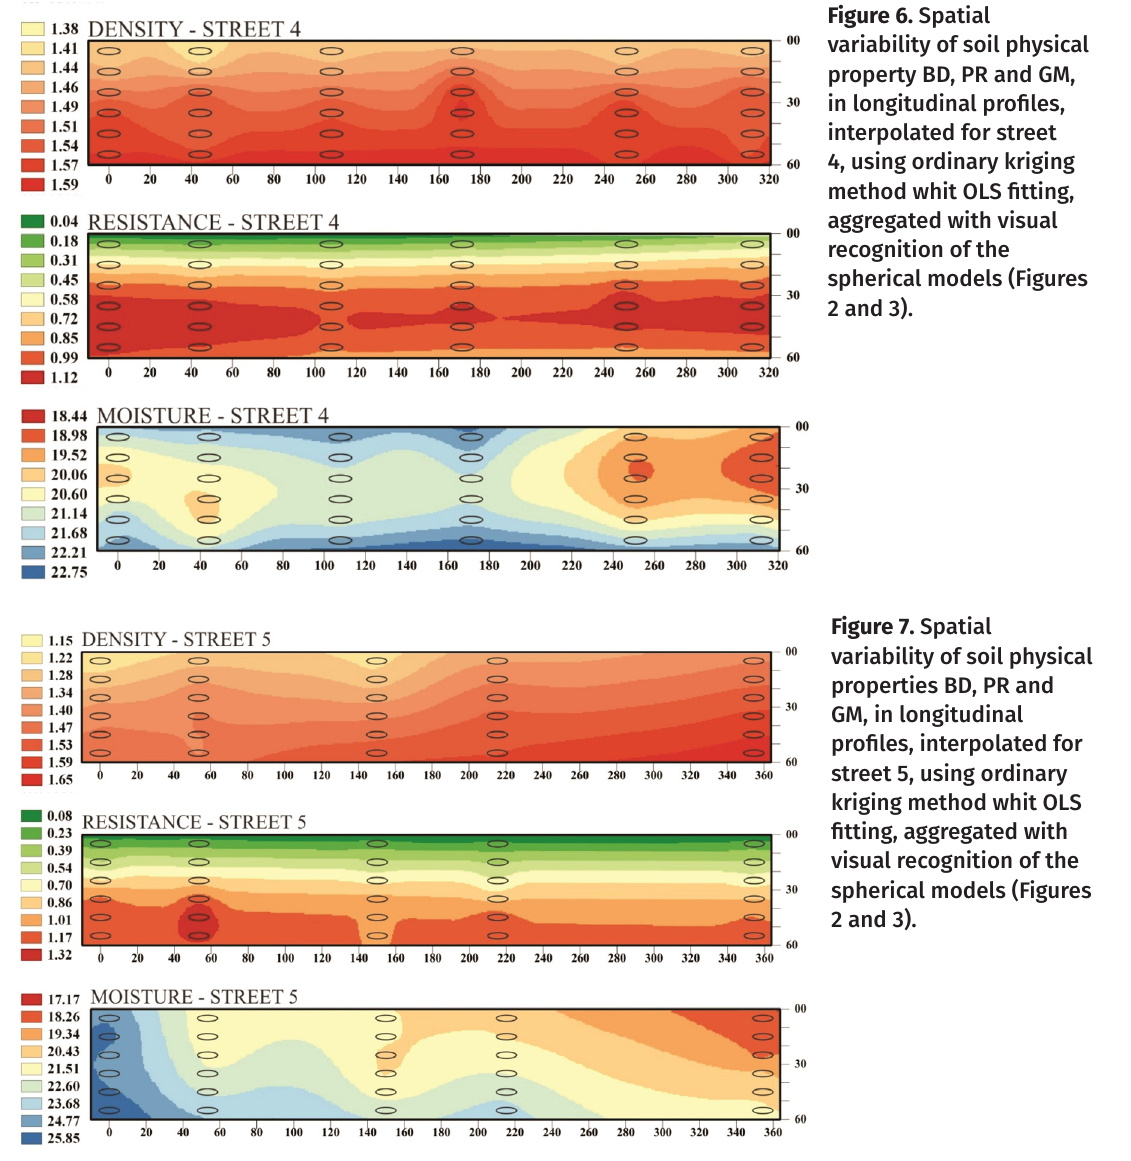
Figure 6. Spatial variability of soil physical property BD, PR and GM, in longitudinal profiles, interpolated for street 4, using ordinary kriging method whit OLS fitting, aggregated with visual recognition of the spherical models (Figures 2 and